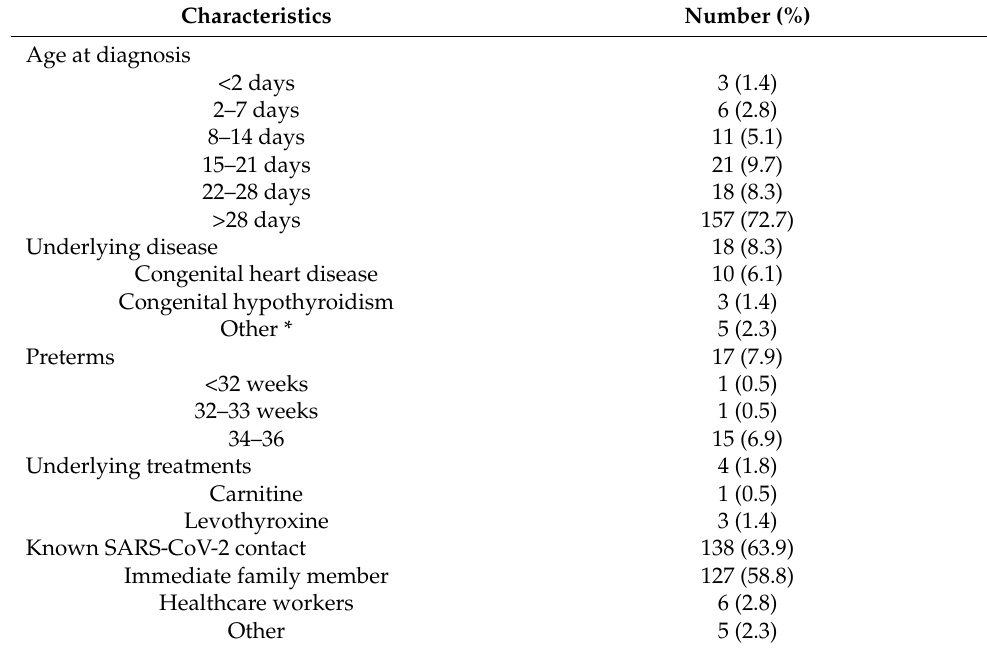
Table 2. Patients’ characteristics.